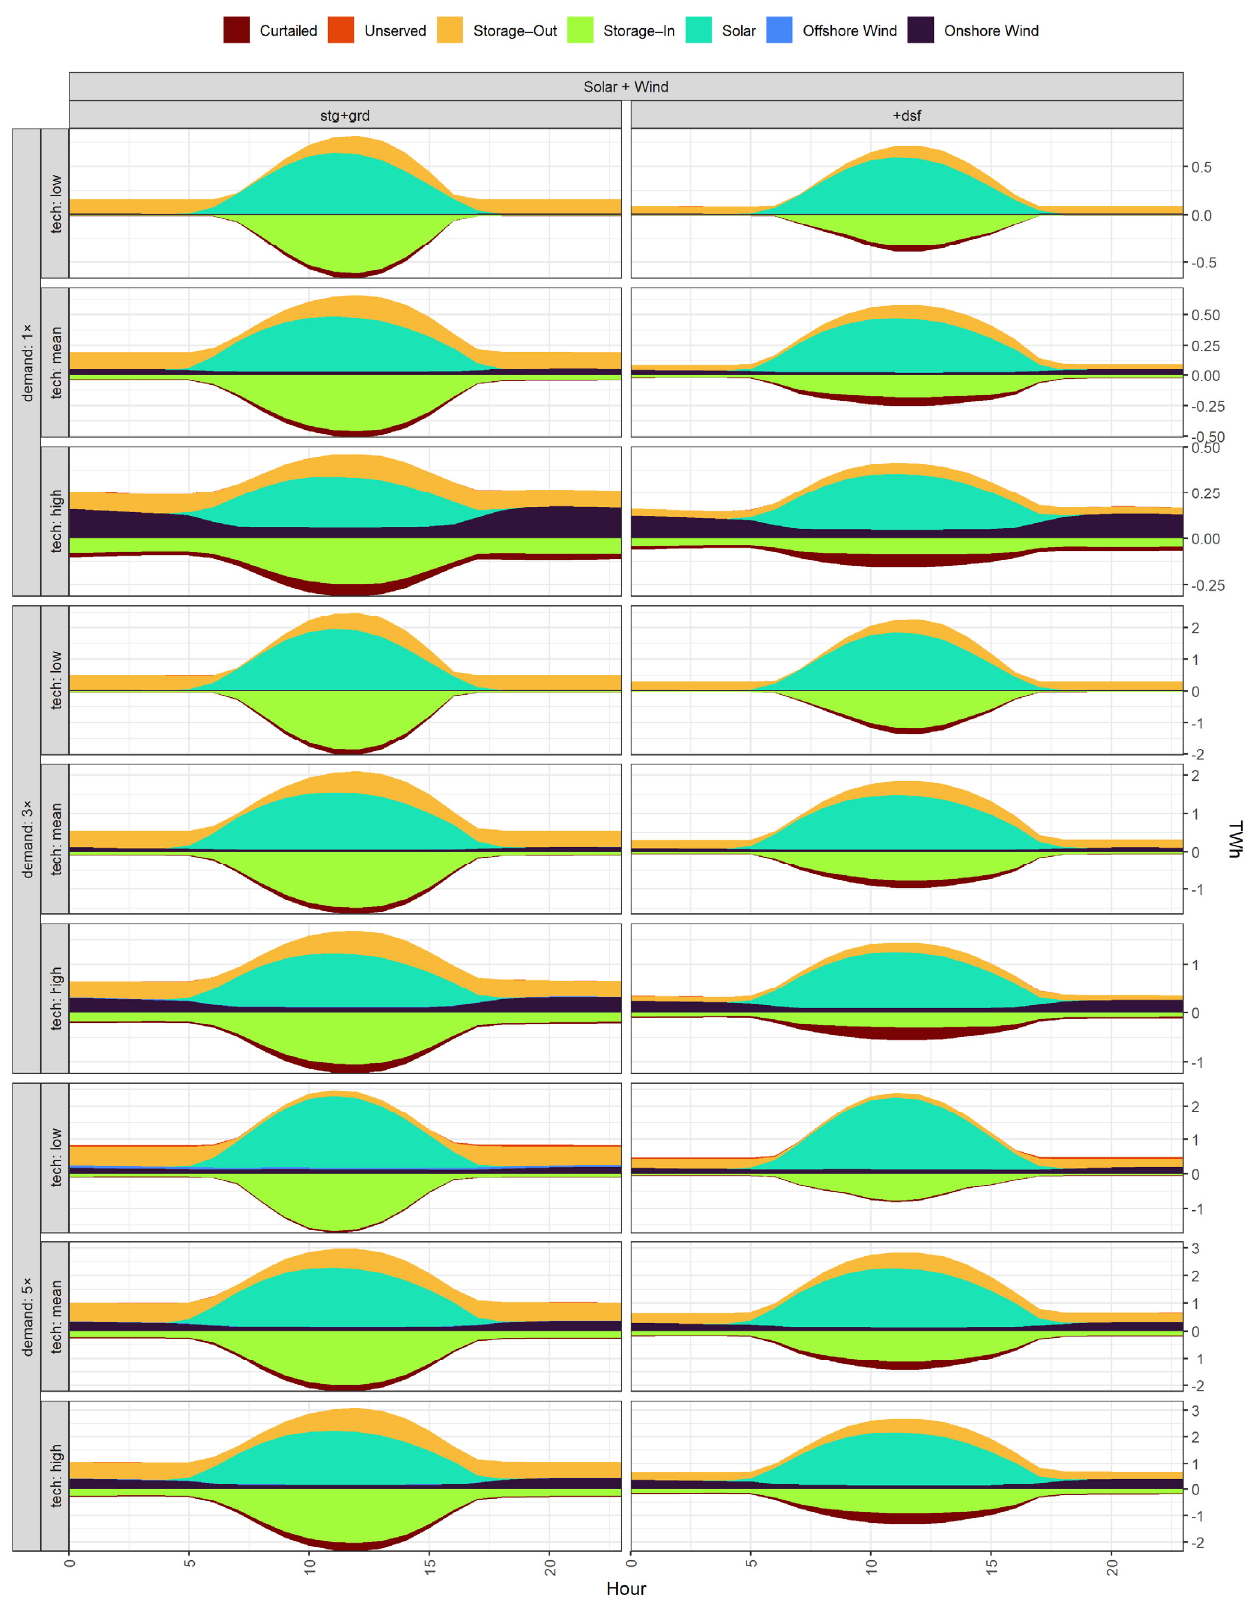
Figure A19. Annual average generation profile by hours in scenarios without and with responsive demand option (‘stg+grd’ and ‘+dsf’, respectively).